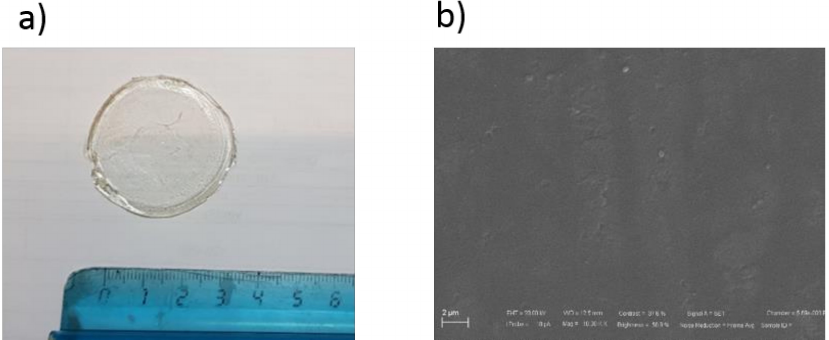
Figure 1. Image ( a ) and SEM picture ( b ) of a typical film obtained by copolymerization of